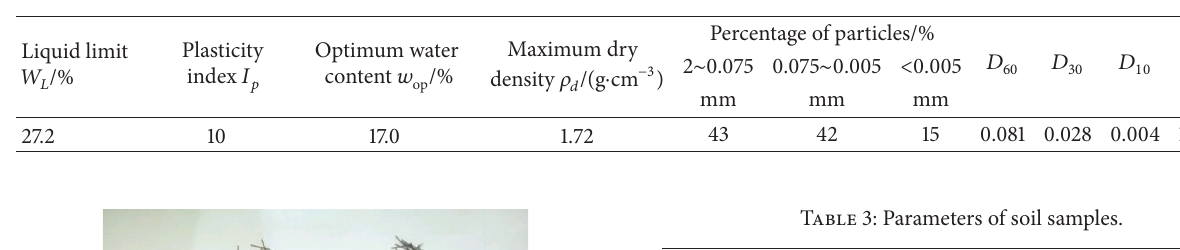
Table 2: Physical behaviors of clay soil.